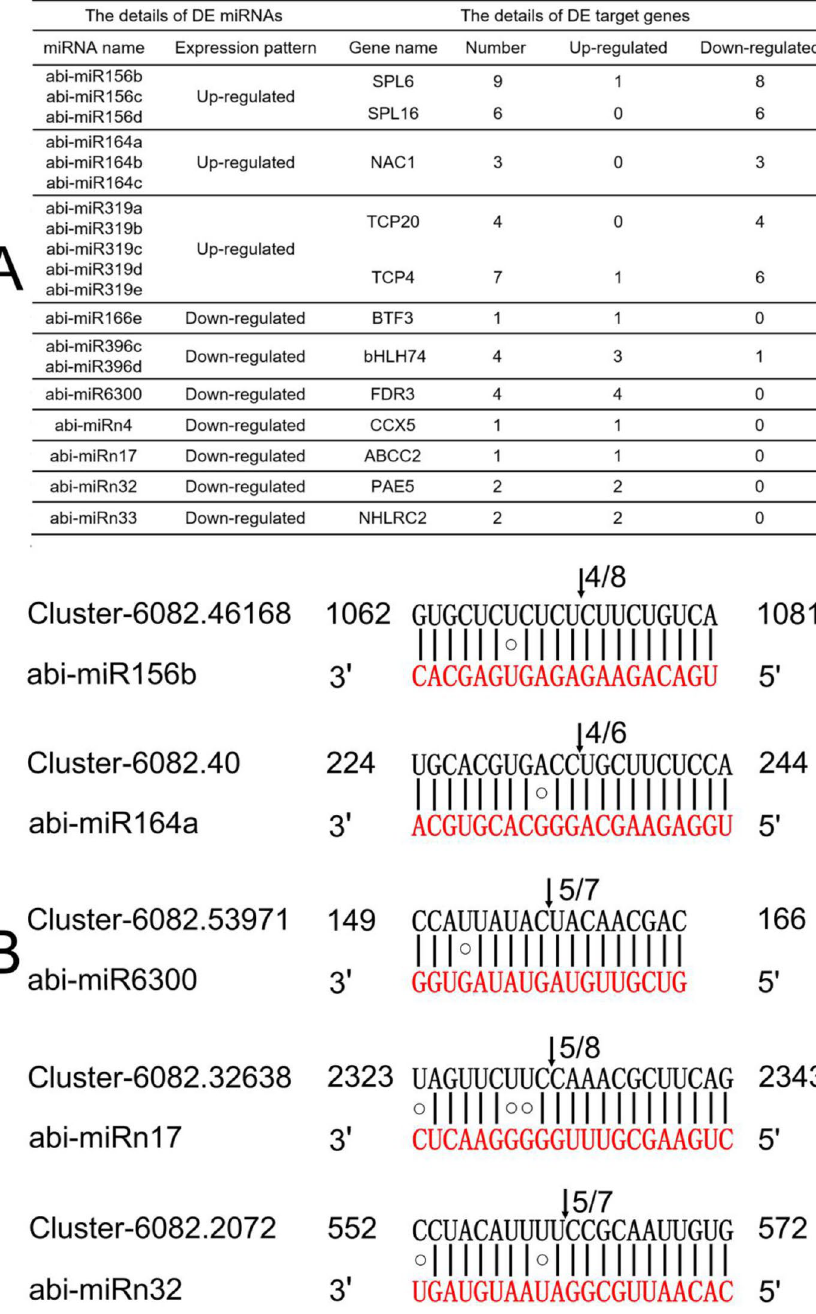
cleavage sites, and numbers represent the clones sequenced and how many were